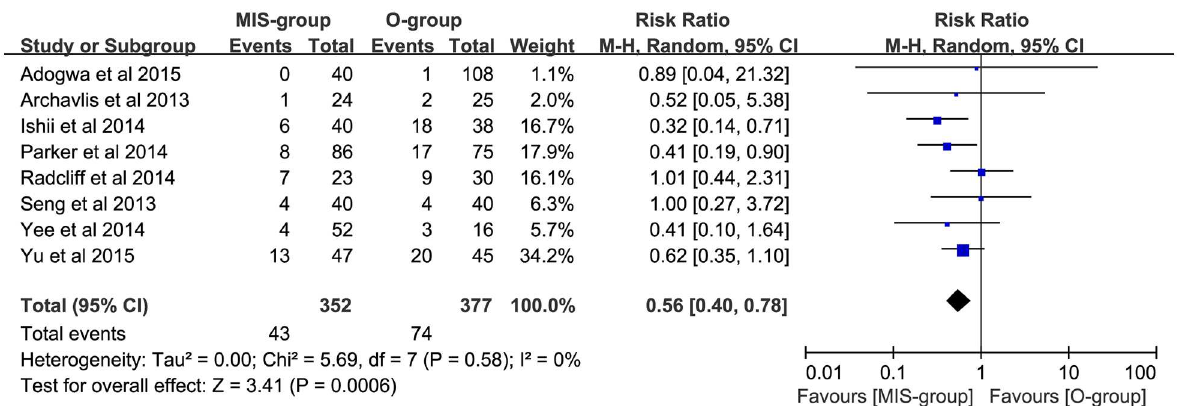
Fig 4. The comparing of symptoms ASDis incident rate between MIS and open grops.